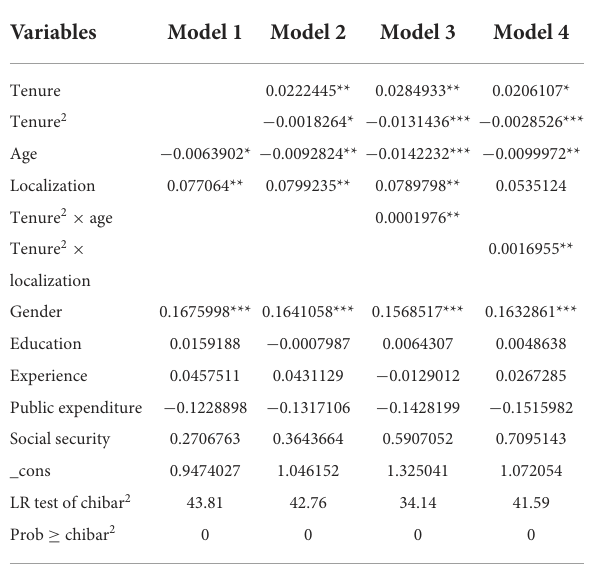
TABLE 3 Results of mediation and moderated mediation regression analyses.